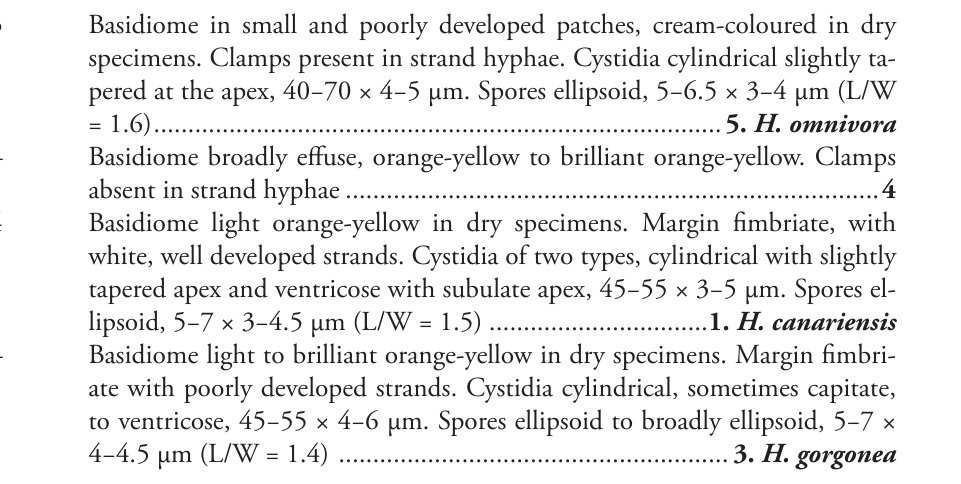
Diagnosis. This species can be recognized by the orange-yellow basidiome, hydnoid hymenophore with long aculei, up to 1,5 mm, white subiculum, and well-developed white strands. Spores ellipsoid 5−7 × 3−4.5 μm (L/W = 1.5). Type. Spain. Canary Islands: El Hierro, Frontera, Sabinar de la Dehesa, 27°44'43"N; 18°07'02"W, 610 m alt., on unidentified wood, 26 January 2007, M.T. Telleria, 17035Tell. (holotype: MA-Fungi 86622). LSU sequence KF528103, ITS se- quence KF483012. Etymology. Named after the Canary Islands where the holotype and paratypes were collected. Description. Basidiome resupinate, effuse, membraneous to ceraceous, yellow (82. v. Y) in fresh specimens and light orange-yellow (70. l. OY) in dry. Hymenophore hydnoid, aculei conical, 0.5−1.5 mm long. Subiculum byssoid, white. Margin fimbri- ate, white, with well-developed white strands. Hyphal system monomitic; subicular hyphae 6−8 μm wide, with clamps, thin to thick-walled; strand hyphae 7−11 μm wide, without clamps, thick-walled; aculei hy- phae 4−5 μm wide, without clamps, thin-walled and growing perpendicular to the substrate; subhymenial hyphae 3−4 μm wide, without clamps, thin-walled, and loosely interwoven. Cystidia of two types: cylindrical with slightly tapered apex and ventri- cose with subulate apex, thin-walled, 45−55 × 3−5 μm. Basidia cylindrical to sub- clavate, 24−28 × 4−6 μm, with 4 sterigmata, basal clamp absent. Spores ellipsoid 5−7 × 3−4.5 μm (L/W = 1.5), thin-walled, colorless, smooth. Ecology and distribution. On decayed wood and plant debris in arid and semi- arid habitats; known only from the Canary